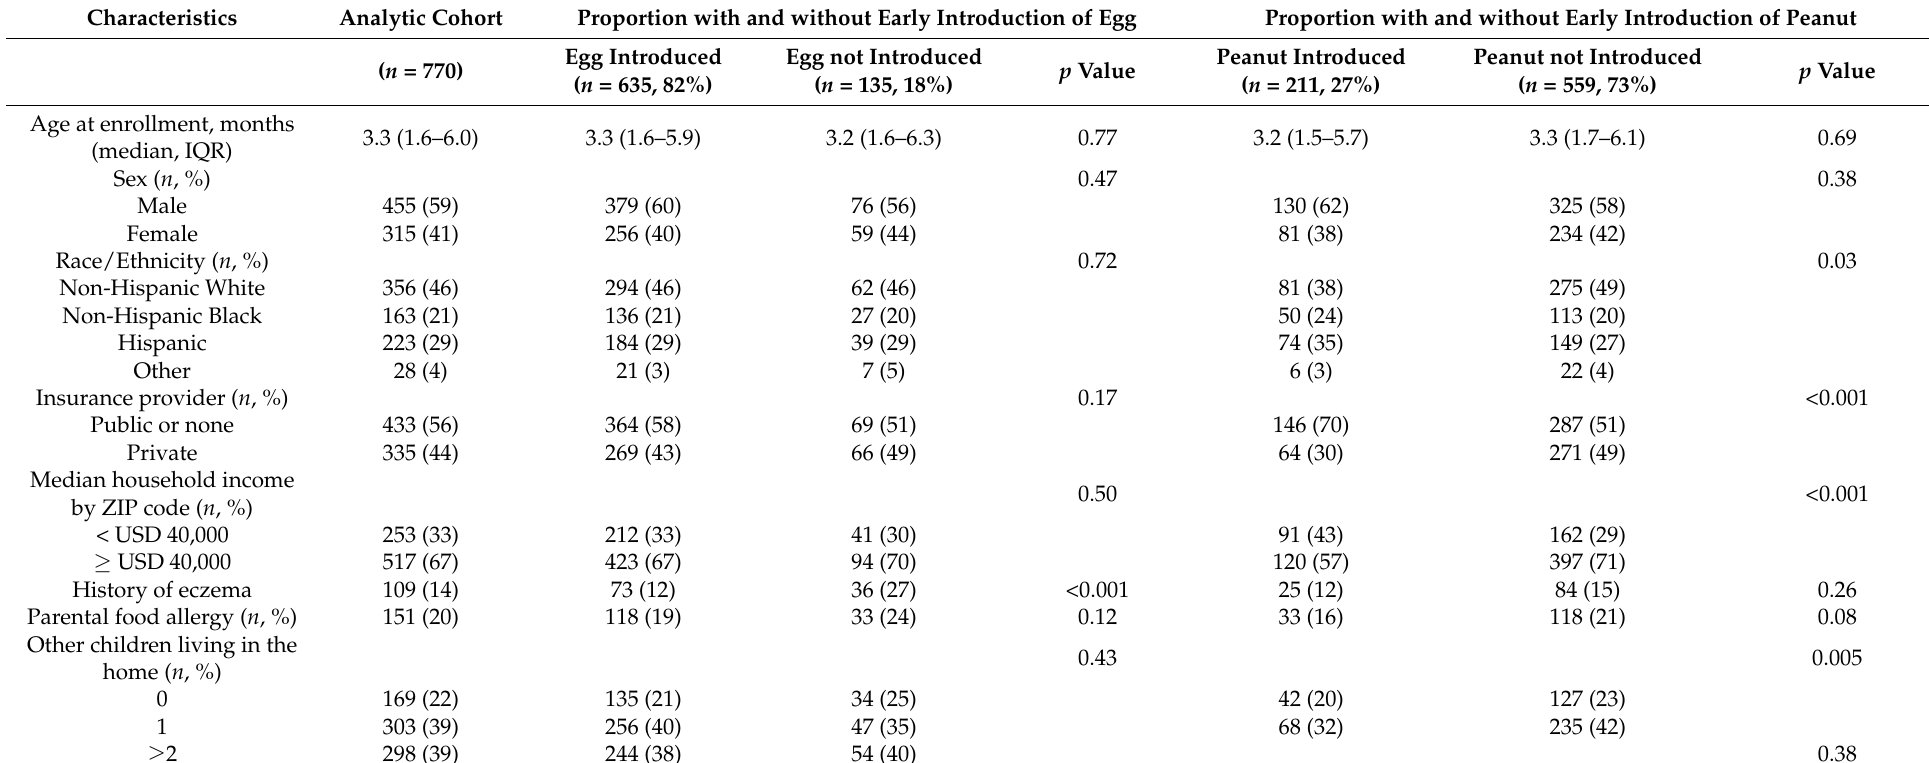
Table 1. Demographics and other characteristics of the analytic cohort at